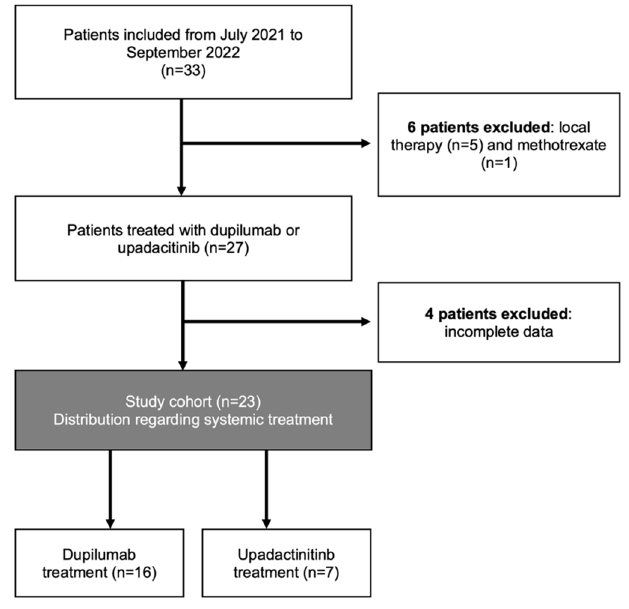
Figure 1. Study cohort.